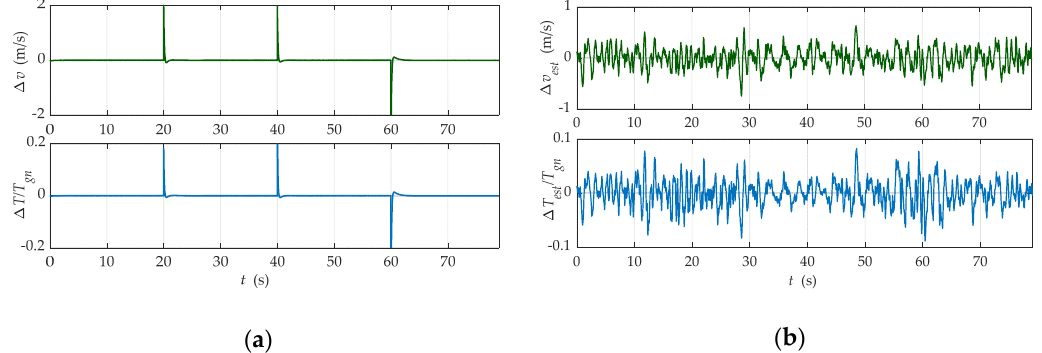
Figure 12. Estimation errors of the wind speed and the aerodynamic torque for the WECS operation shown in Figure 10 ( a ) and Figure 11 ( b ).